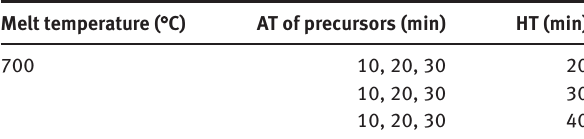
Table 2: Processing conditions for the fabrication of composites. Melt temperature ( ° C) AT of precursors (min)